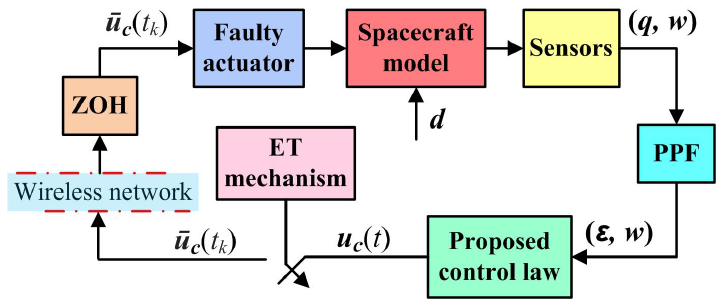
Figure 1. Schematics of the proposed PPF based ET